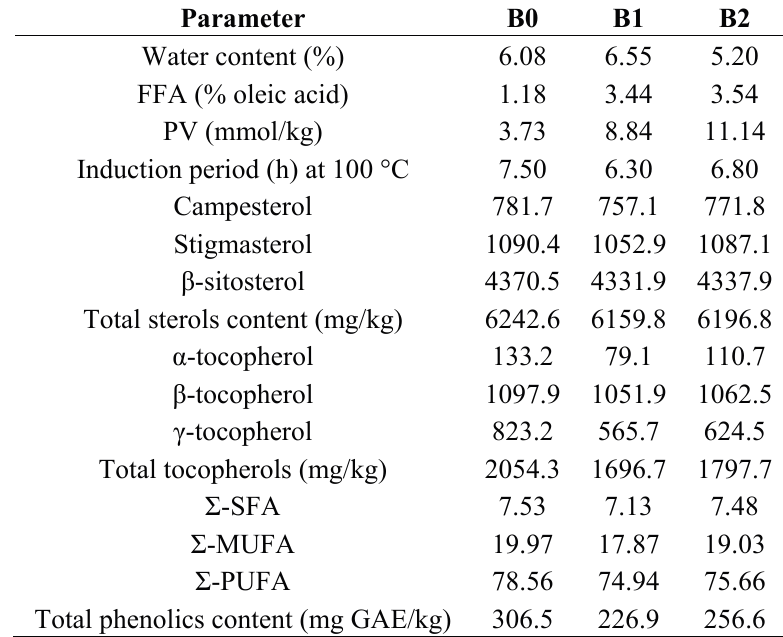
Table 8. Chemical composition of oils extracted from blackberry pomaces grown in Serbia